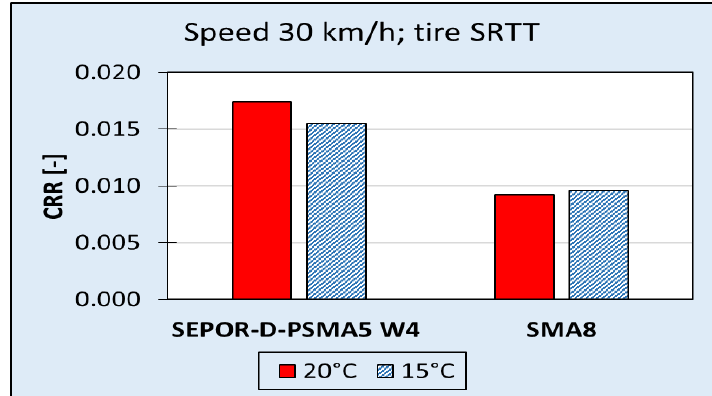
Figure 27. Coefficient of Rolling Resistance (CRR) for SEPOR-D-PSMA5 W4 as measured on the roadwheel facility at −15 °C.